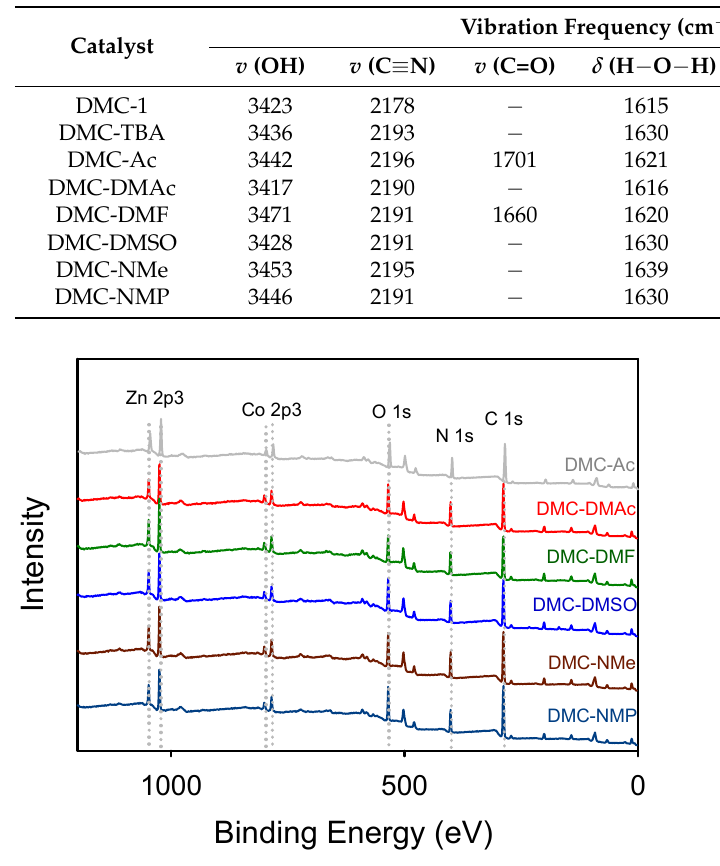
Figure 3. XPS spectra of the DMC catalysts.